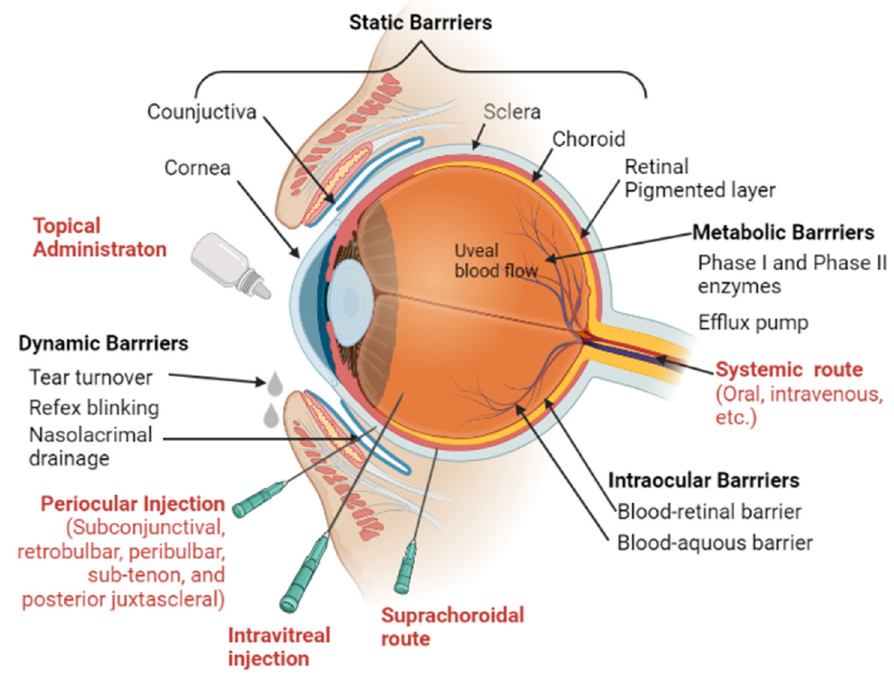
Figure 3. Barriers to ocular drug delivery and routes of ocular drug delivery. Static, dynamic, intraocular, and metabolic barriers to the topical administration of therapeutic agents to the anterior surface of the eye and to the posterior segment are illustrated. Image was created in BioRender.com. Table 1. Summary of key physicochemical parameters of neuroprotective